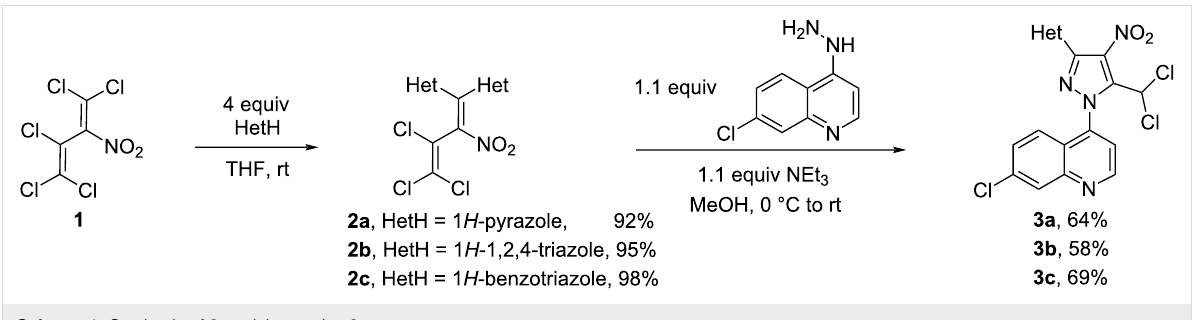
As the 4-amino-substituted 7-chloroquinoline is the essential fragment of chloroquine and its derivatives, we have designed and synthesized a series of pyrazoles containing this fragment in position 1 of the pyrazole ring with the aim to obtain new compounds with antimalarial and/or anti-SARS-CoV